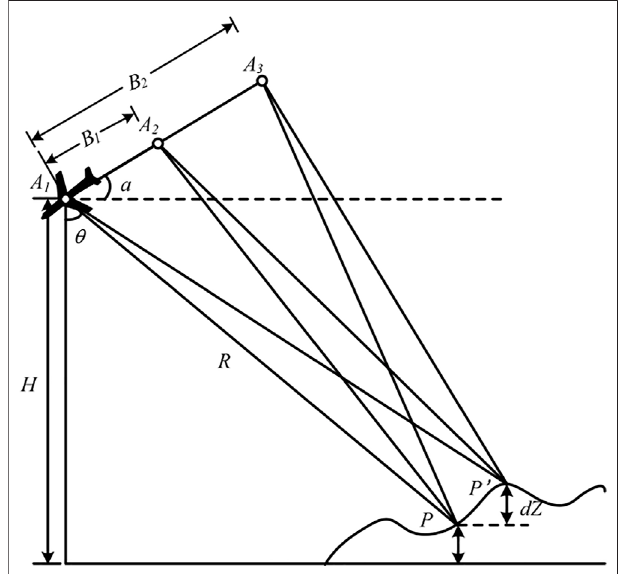
FIGURE 1 | Geometry of dual-baseline